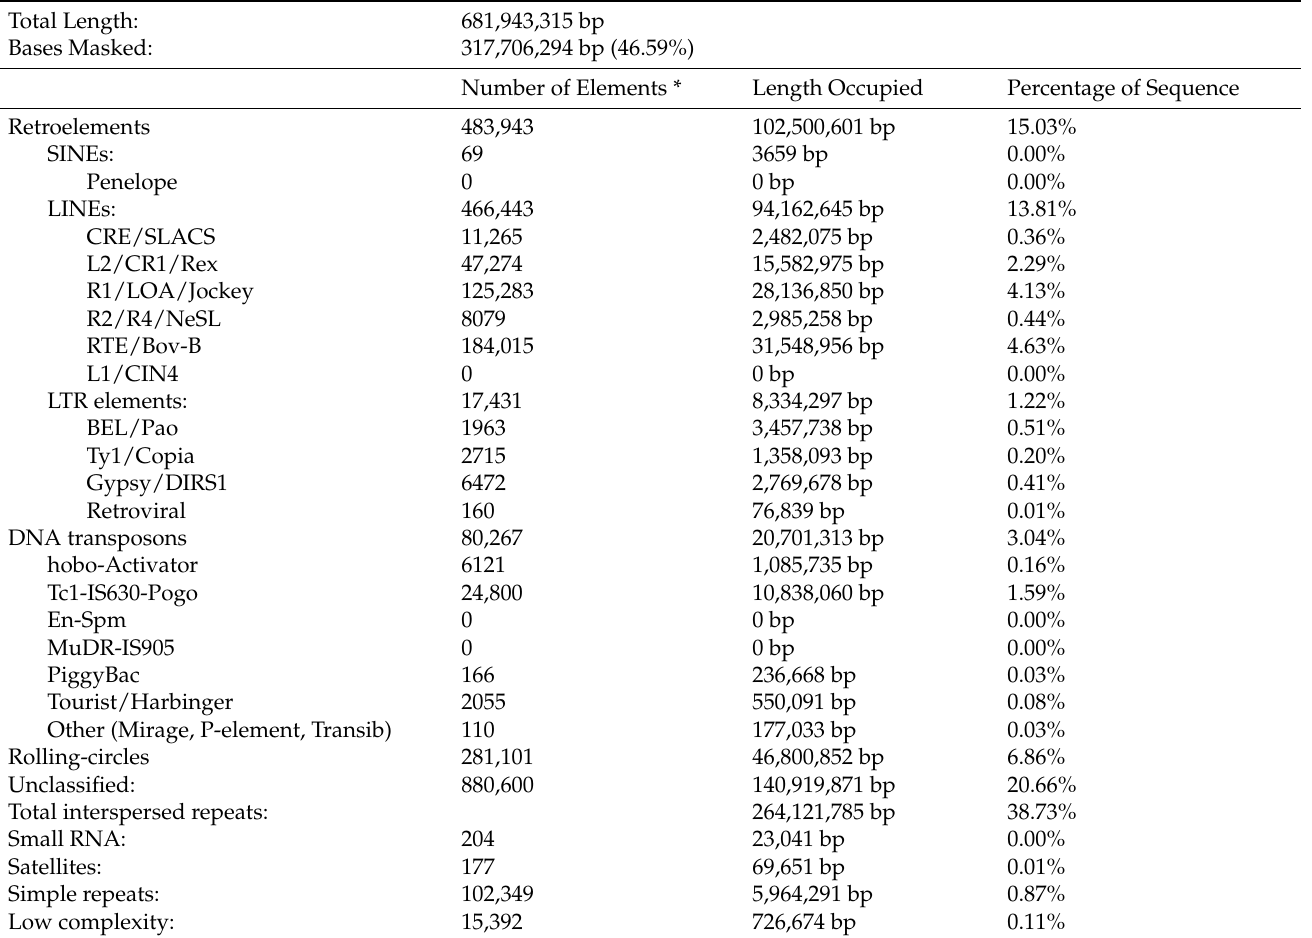
Table 3. Transposons and repetitive regions in M. separata